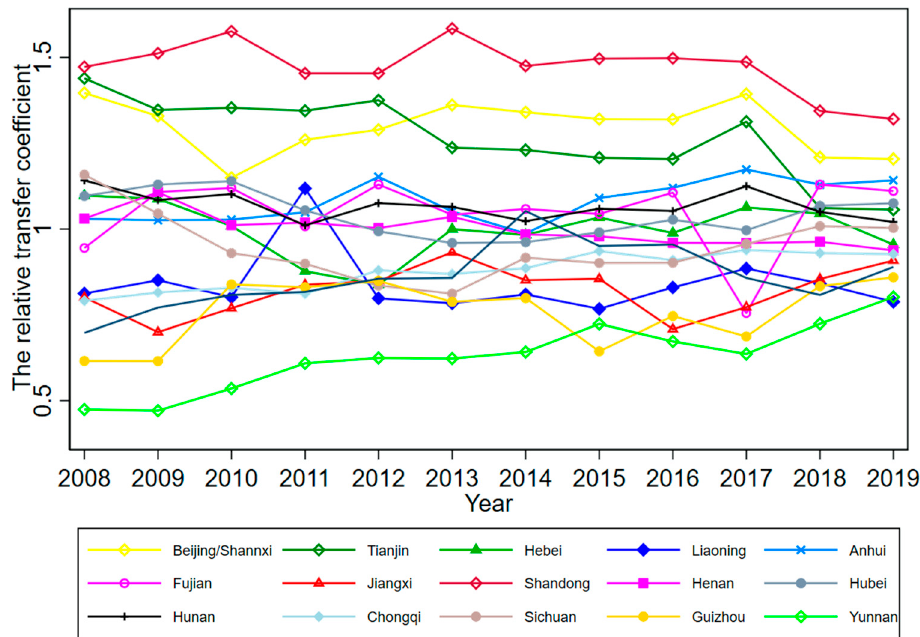
Figure 6. Relative transfer paths of HQDM levels in Club 3 member provinces.